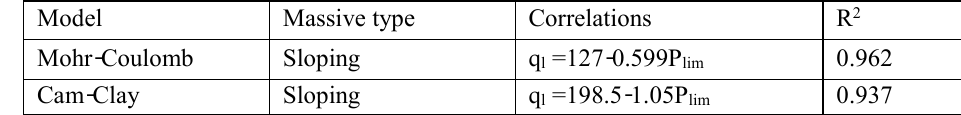
Correlations between limit pressure and bearing